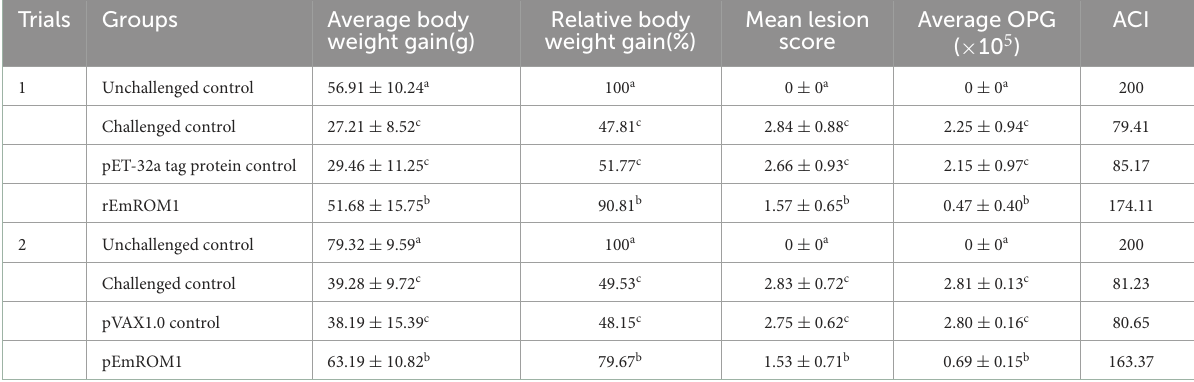
TABLE 2 Protective efficacy of rEmROM1 and pEmROM1 against E. maxima challenge ( n = 30, value = Mean ±